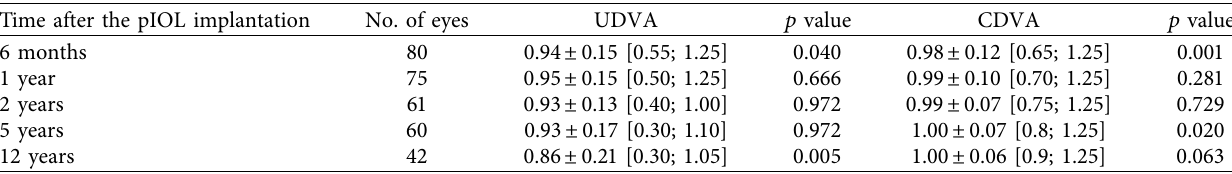
Table 3: Postoperative visual acuity results (Snellen decimal scale).